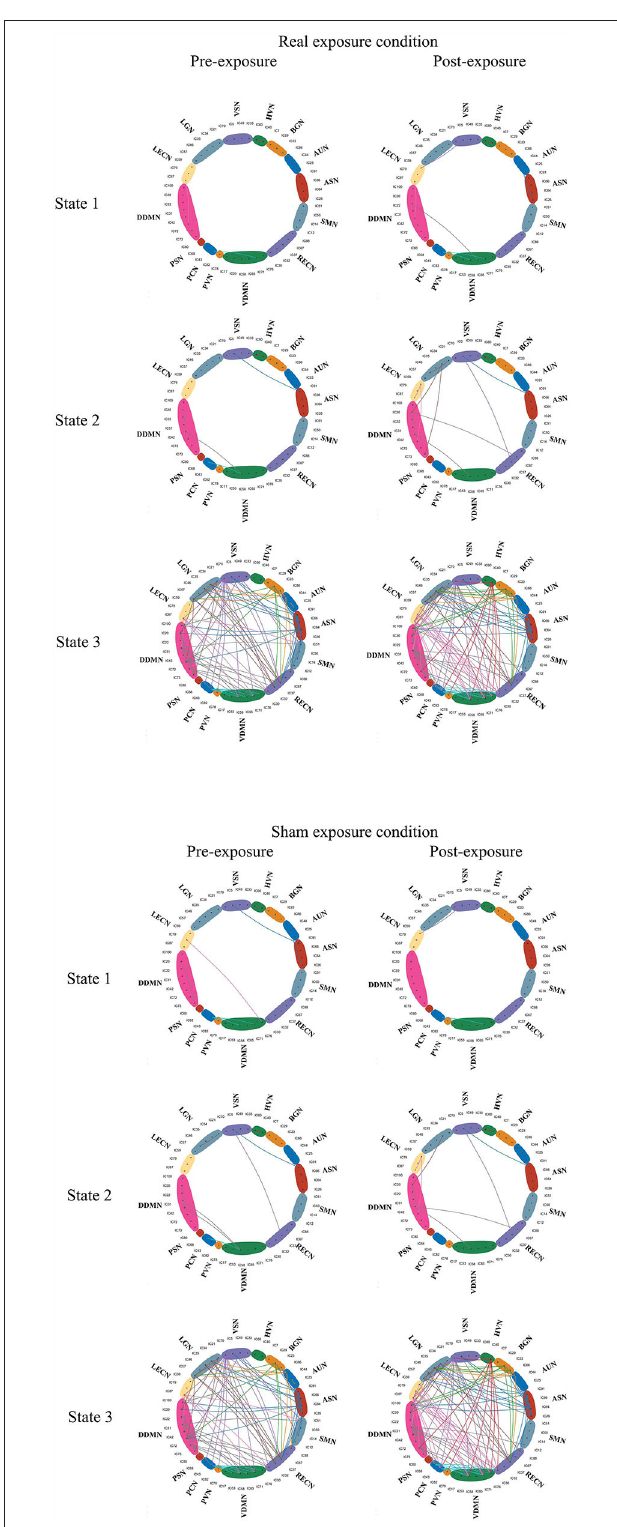
FIGURE 8 | The states derived from the experiments. Connections with correlation coefficients exceeding 0.6 are shown in the Figure